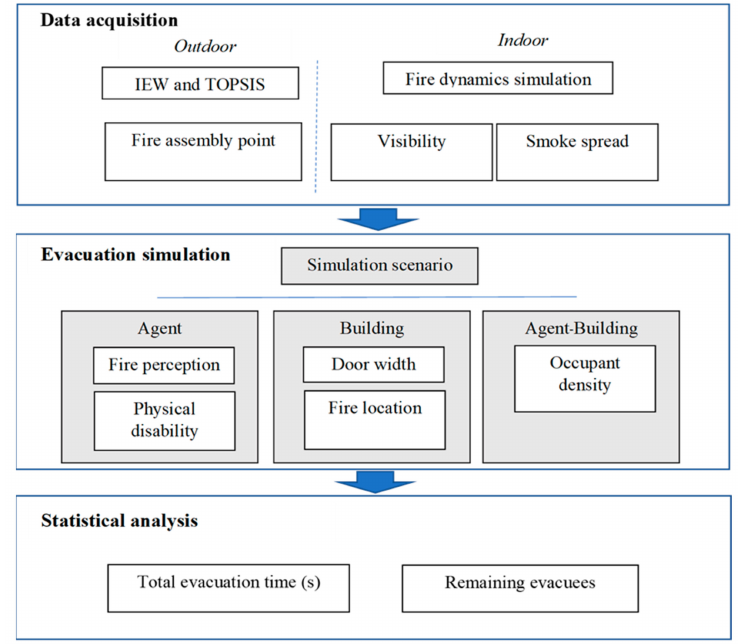
Figure 2. Experimental plan of the proposed